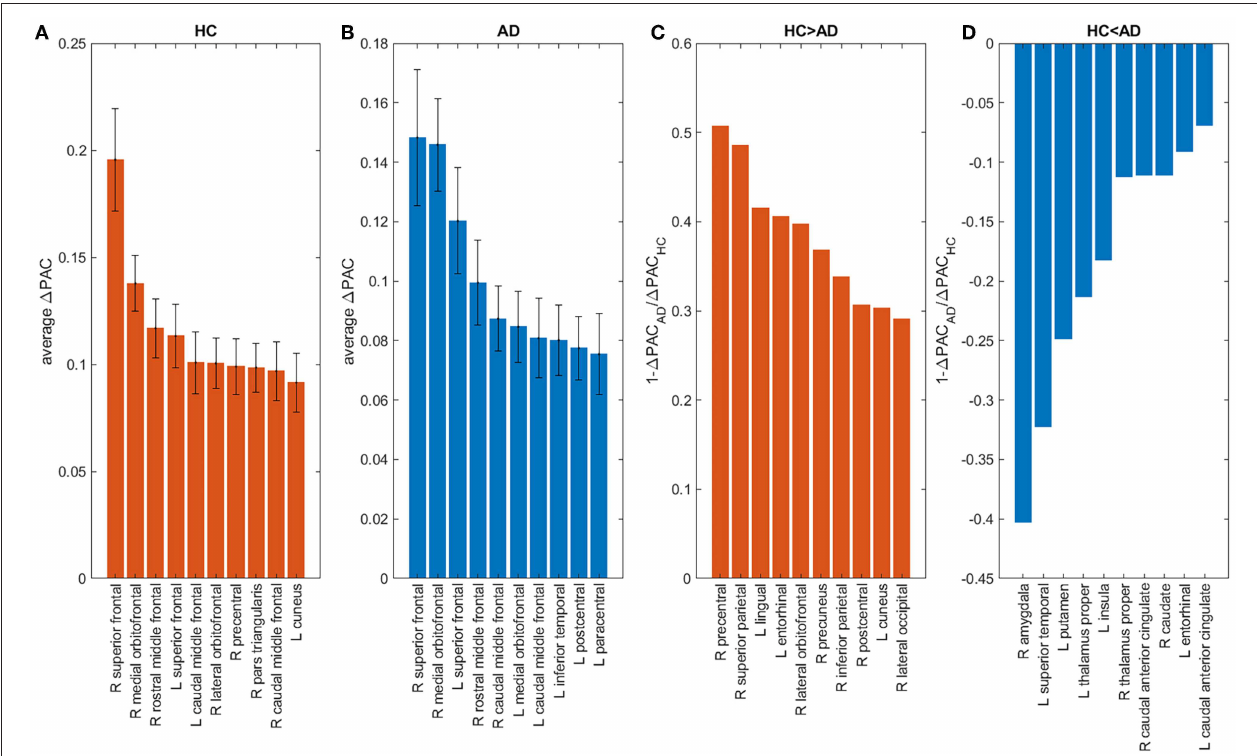
FIGURE 8 | Influence of brain areas on PAC: areas that when removed from the network change PAC the most in HC (A) , AD (B) . Areas for which the change was larger in HC (AD) than in AD (HC) appear in panels (C,D) . “L” and “R” denote left and right hemispheres,